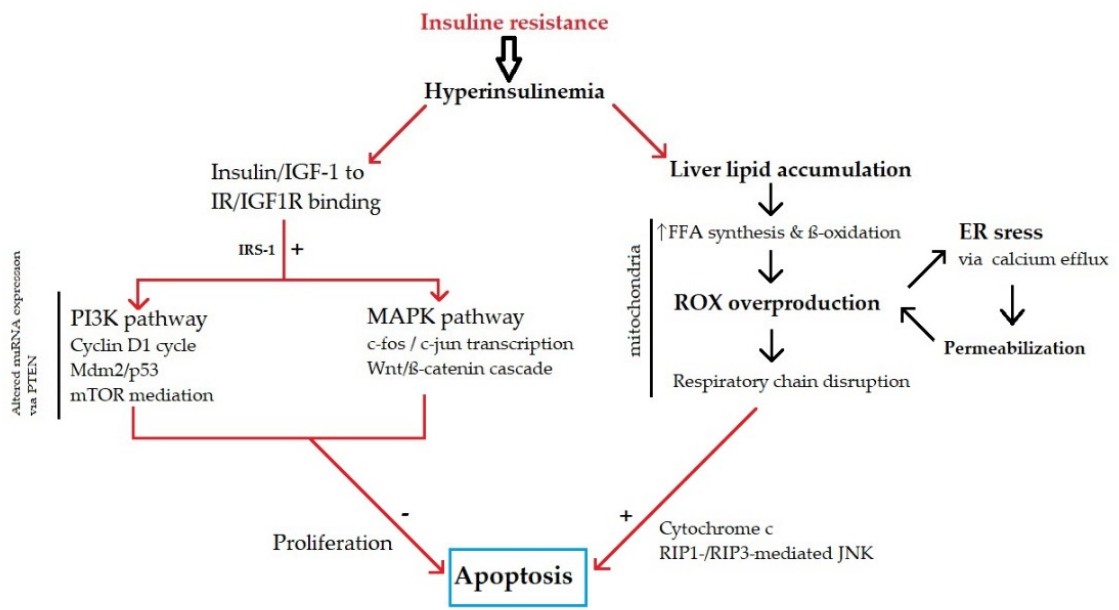
Figure 1. Metabolic pathogenesis of non-alcoholic fatty liver disease (NAFLD)-related hepatocellular carcinoma (HCC) (based on the references [45–52]). PI3K—phosphoinositide 3-kinase; MAPK—mitogen-activated protein kinase; IGF-1—insulin-like growth factor-1 (IGF-1); IRS-1—insulin receptor substrate 1; mTOR—mechanistic target of rapamycin; FFAs—free fatty acids; ER—endoplasmatic reticulum; PTEN—phosphatase and tensin homolog; RIP—receptor-interacting serine/threonine kinase; JNK—c-Jun N-terminal kinase.